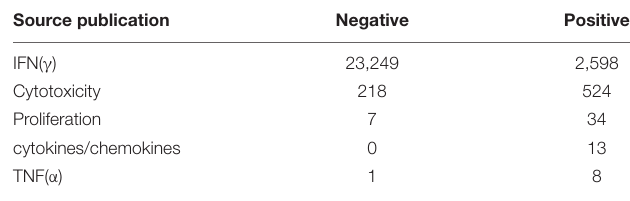
TABLE 2 | The number of pHLA complexes used for training per immunogenic assay